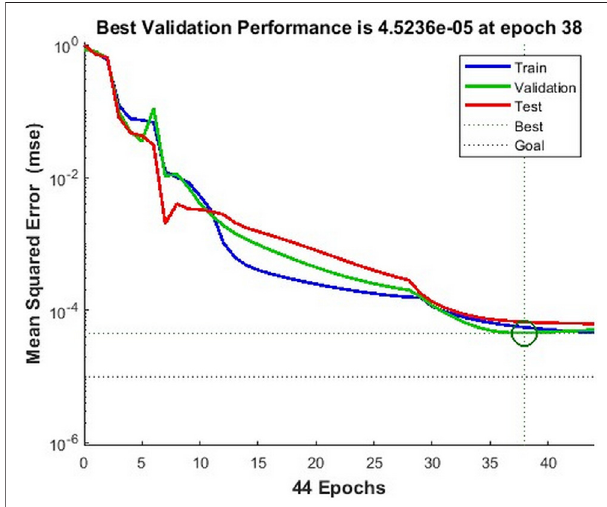
FIGURE 4 | Training performance of the time-dependent model for leukocyte